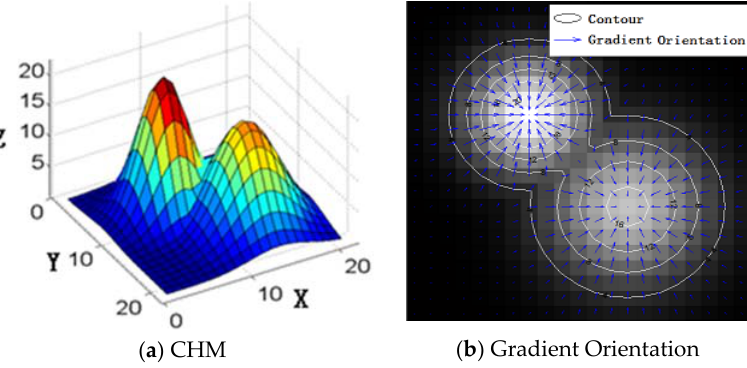
Figure 3. Three ‐ dimensional display of canopy height model (CHM) ( a ) and gradient orientation ( b ).